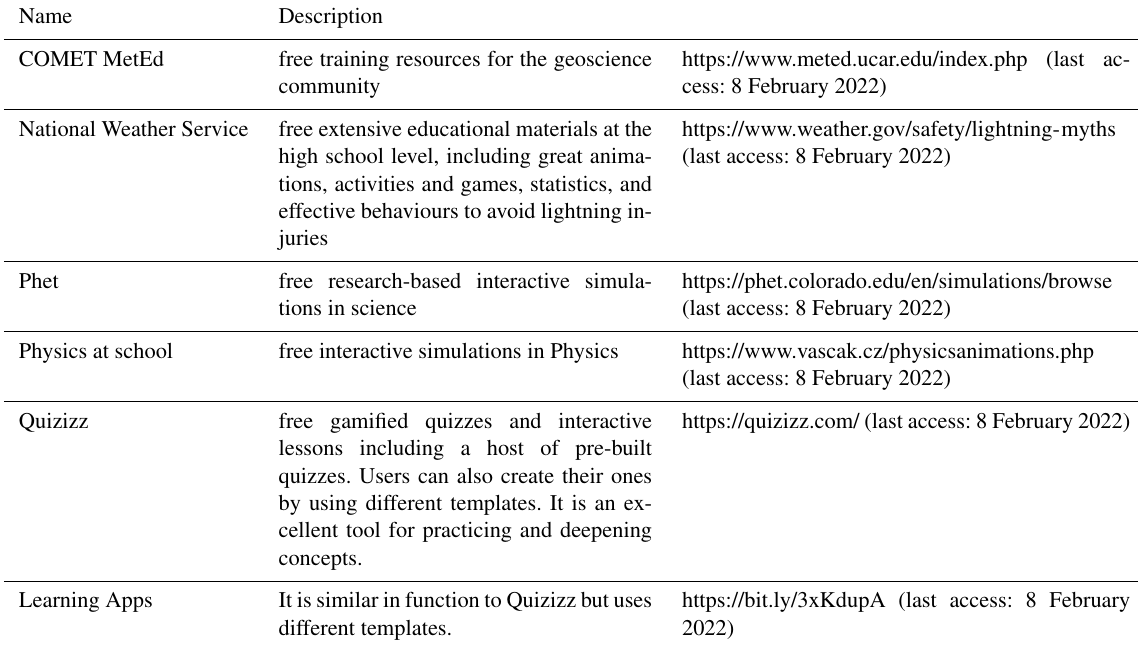
Table 1. The most used apps and simulations in the classroom activities.